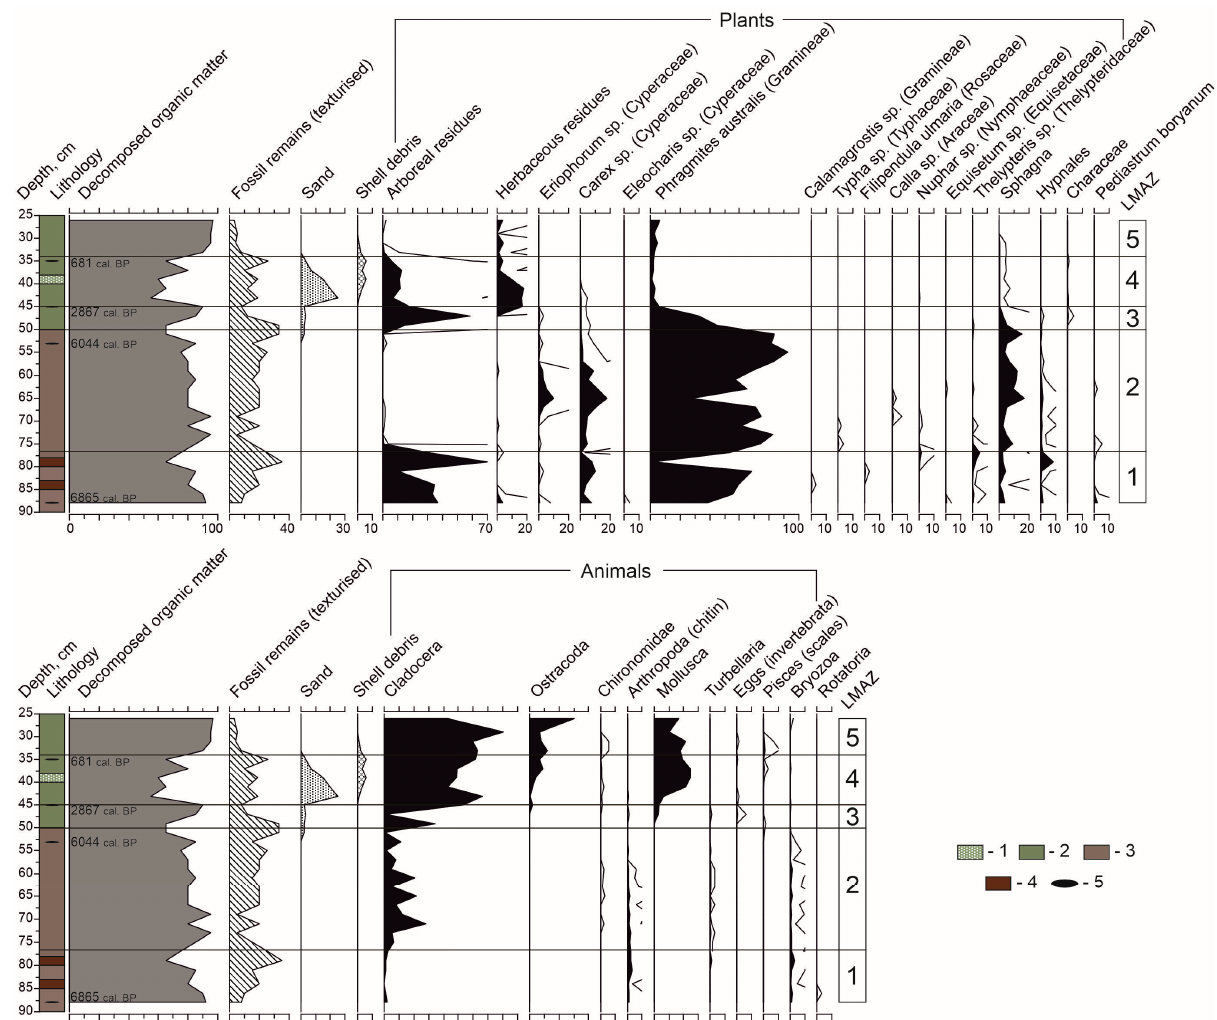
Figure 2. Results of analysis of the macroremains of bottom sediments from the Curonian Lagoon and lithological description of the column (1 — mollusk shell clusters, 2 — fine, silty gyttja, 3 — peaty gyttja, 4 — fen peat, 5 — location of 14 C dated samples).